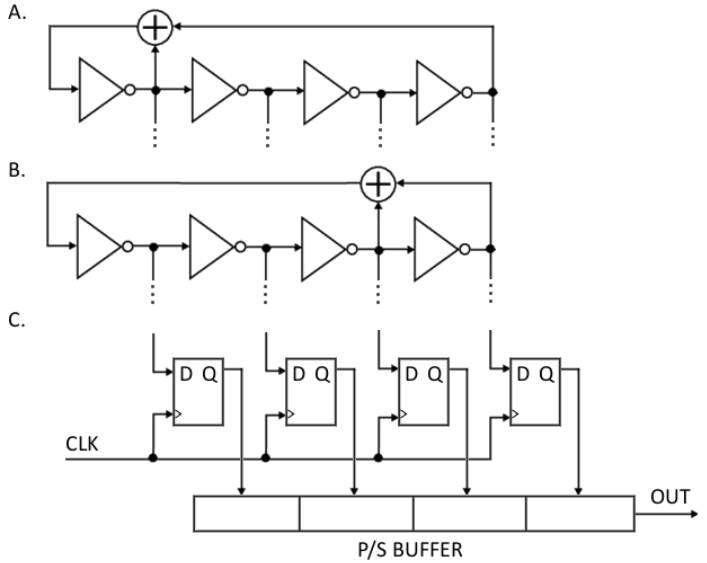
Figure 5. Experimental FPGA setup. ( A ) x 4 + x + 1 FIRO, ( B ) x 4 + x 3 + 1 FIRO, ( C ) internal FIRO state sampler.